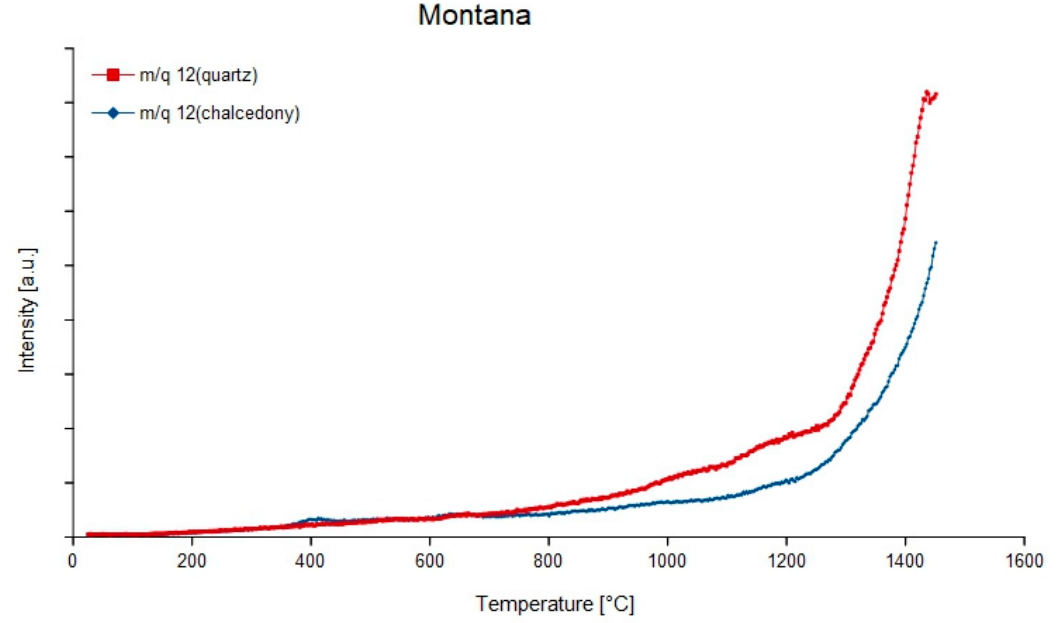
Figure 12. Degassing curves m/q = 12 (C) of quartz and chalcedony from the Montana agate showing exponential shape.